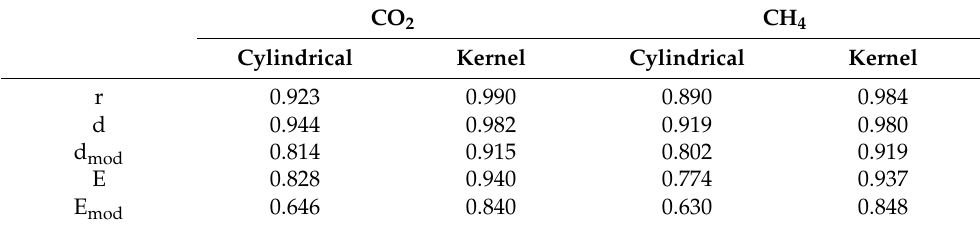
Table 4. Statistics used to compare mean and modelled annual